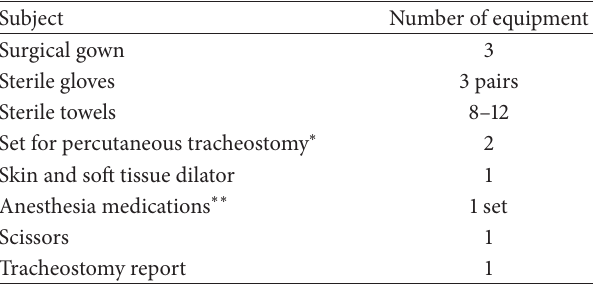
Table 1: Standardized set for percutaneous tracheostomy. ICU Outreach Team, Soroka Medical